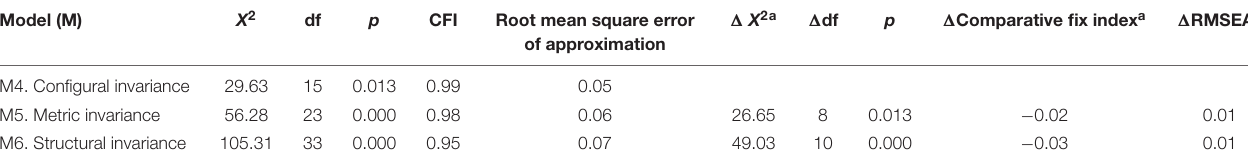
TABLE 7 | Measurement invariance across PR-Comp